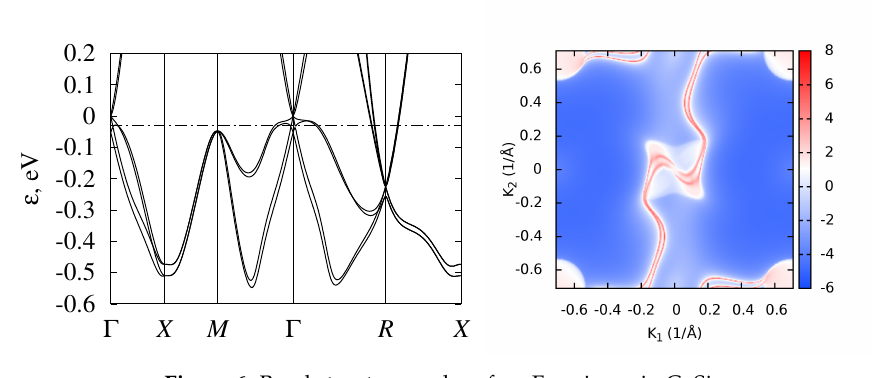
Figure 6. Band structure and surface Fermi arcs in CoSi.